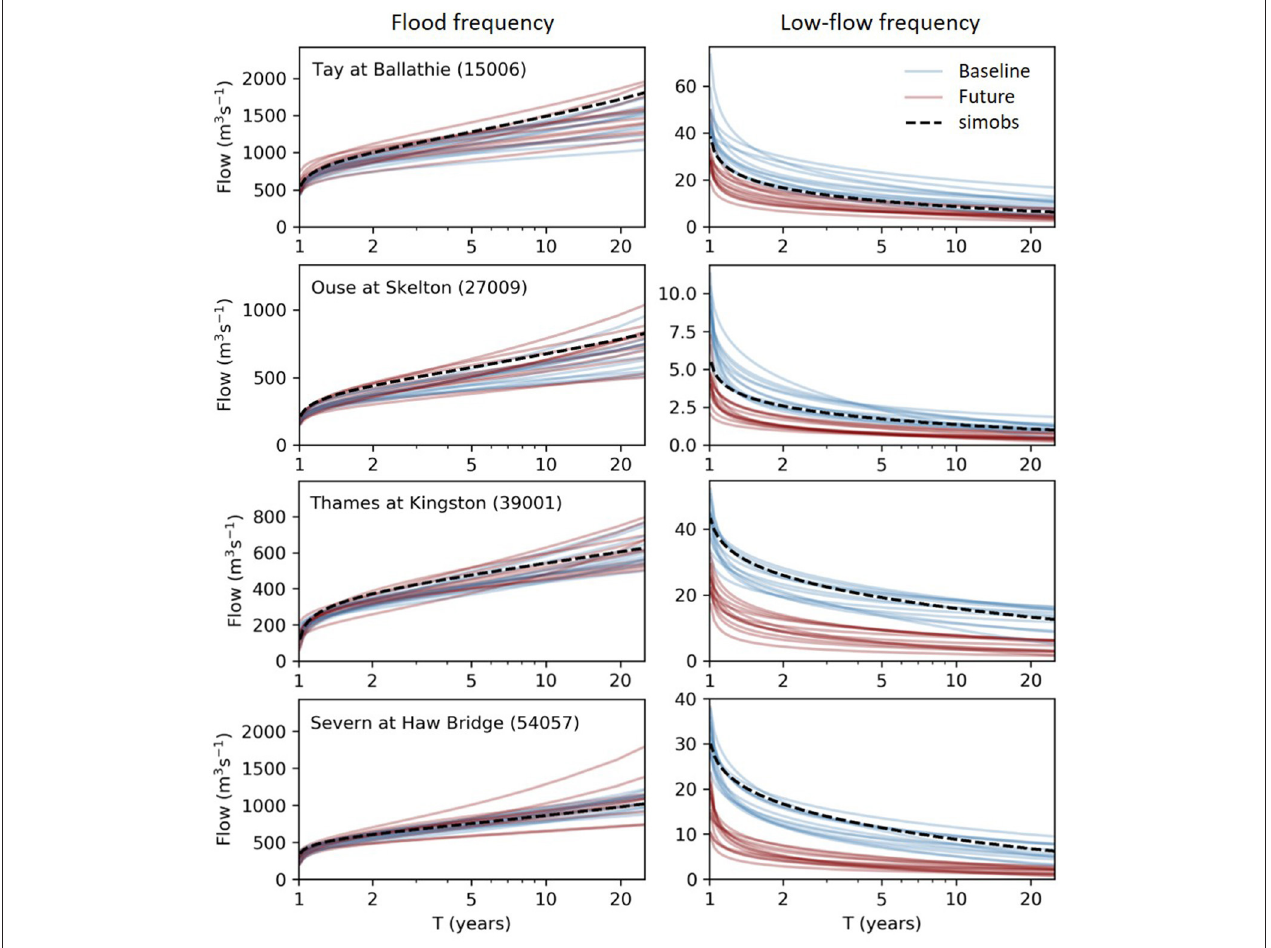
FIGURE 2 | Flow frequency curves for example catchments, derived from annual maximum (left) and annual minimum (right) flows. Flow frequency curves are given for baseline (1983–2012) and future (2051–2080) periods using modelled flows driven by the 12 ensemble climate projections. A flow frequency curve has also been produced using modelled flows driven by observed data for each catchment, to indicate climate model data performance over the observed